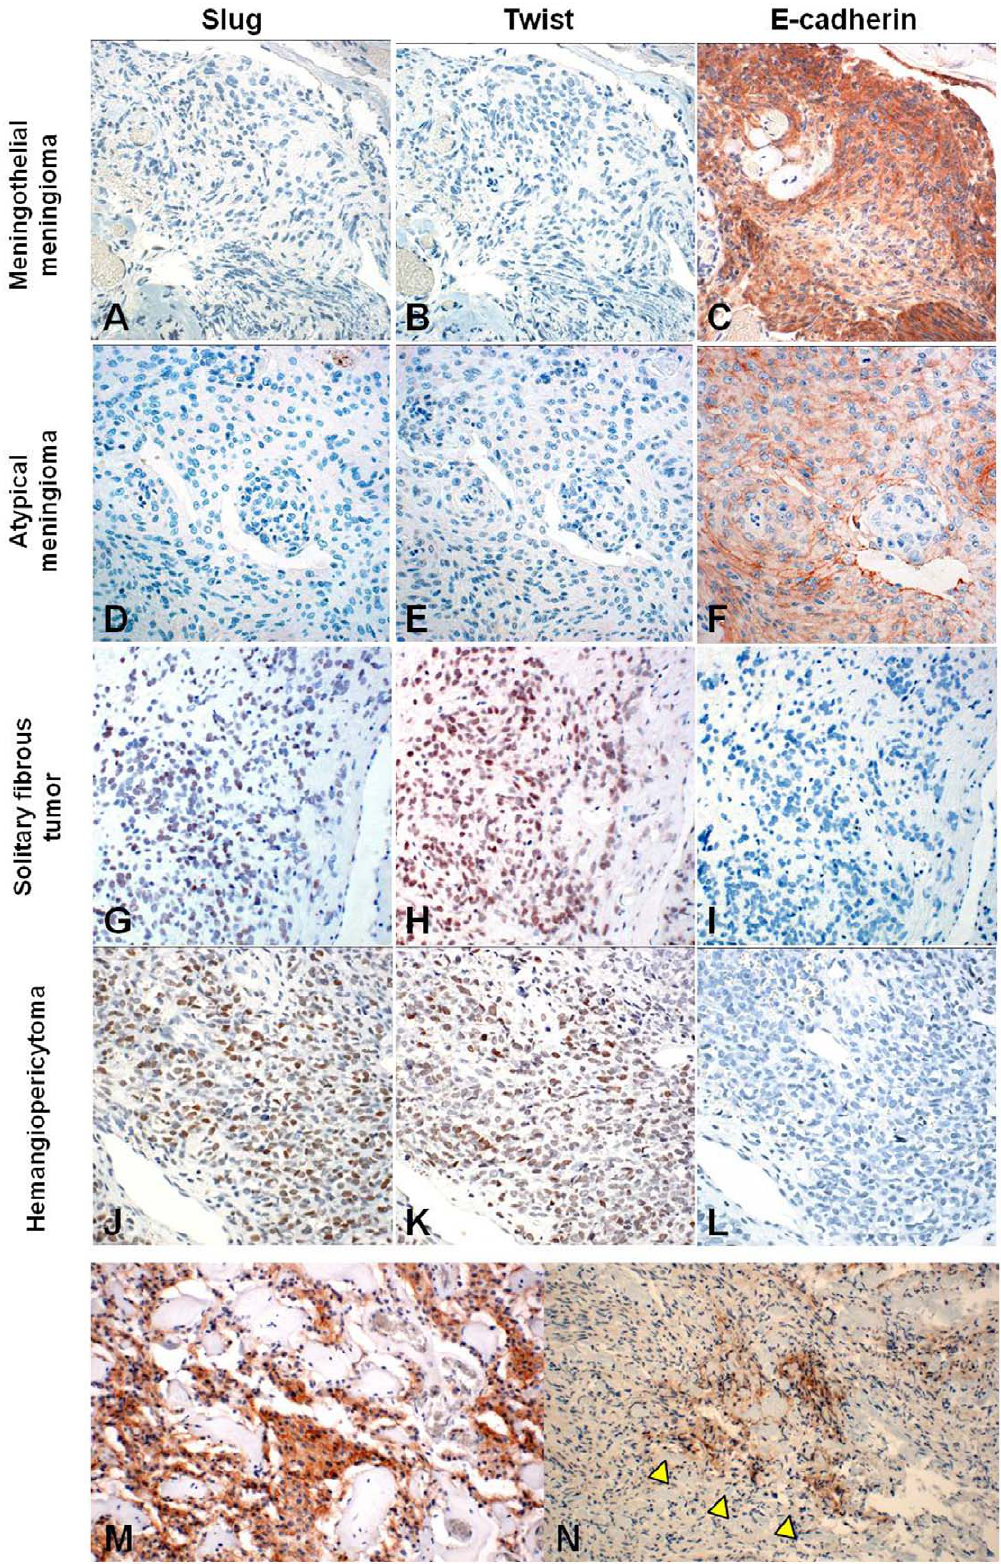
Figure 2. The expression of Slug, Twist, and E-cadherin in meningeal tumors. Consecutive sections of meningothelial meningioma (A–C), atypical meningioma (D–F), solitary fibrous tumor (G–I), and hemangiopericytoma (J–L). Neoplastic cells in meningothelial and atypical meningiomas are negative in immunostaining for Slug (A, D) and Twist (B, E), but are positive for E-cadherin antibody (C, F). The intensity of E-cadherin staining